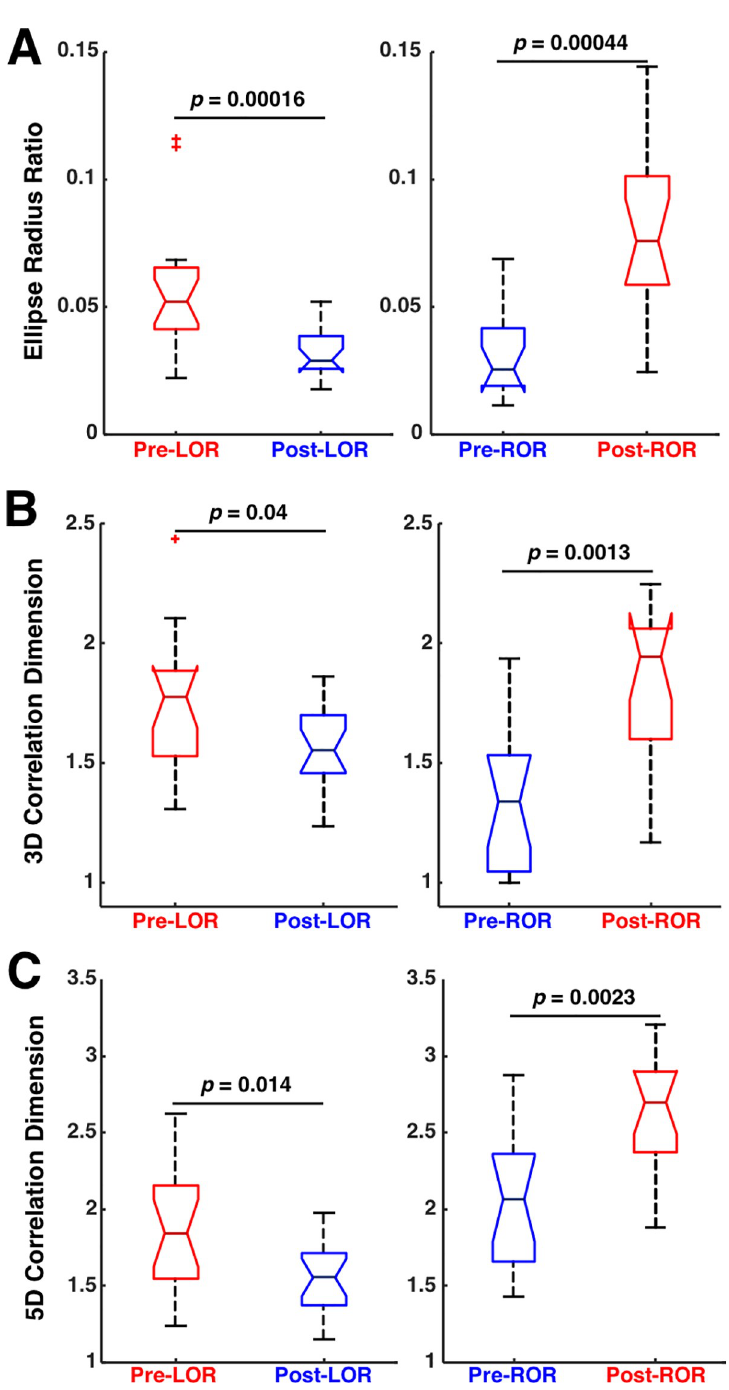
Fig 6. Attractor characterization measures before and after loss and recovery of response. A) Ellipse radius ratio (ERR) of three-dimensional attractors significantly decreases in the transition preceding loss of response (LOR) to the post-LOR state. ERR significantly increases in the transition that precedes recovery of response (ROR) to the post- ROR state. B) Correlation dimension (CD) of three-dimensional attractors decreases from pre- to post-LOR, but not significantly. CD increases significantly between the pre- and post-ROR state. C) Correlation dimension of five- dimensional attractors decreases significantly from pre- to post-LOR, and increases significantly between the pre- and post-ROR state. Reported p-values are